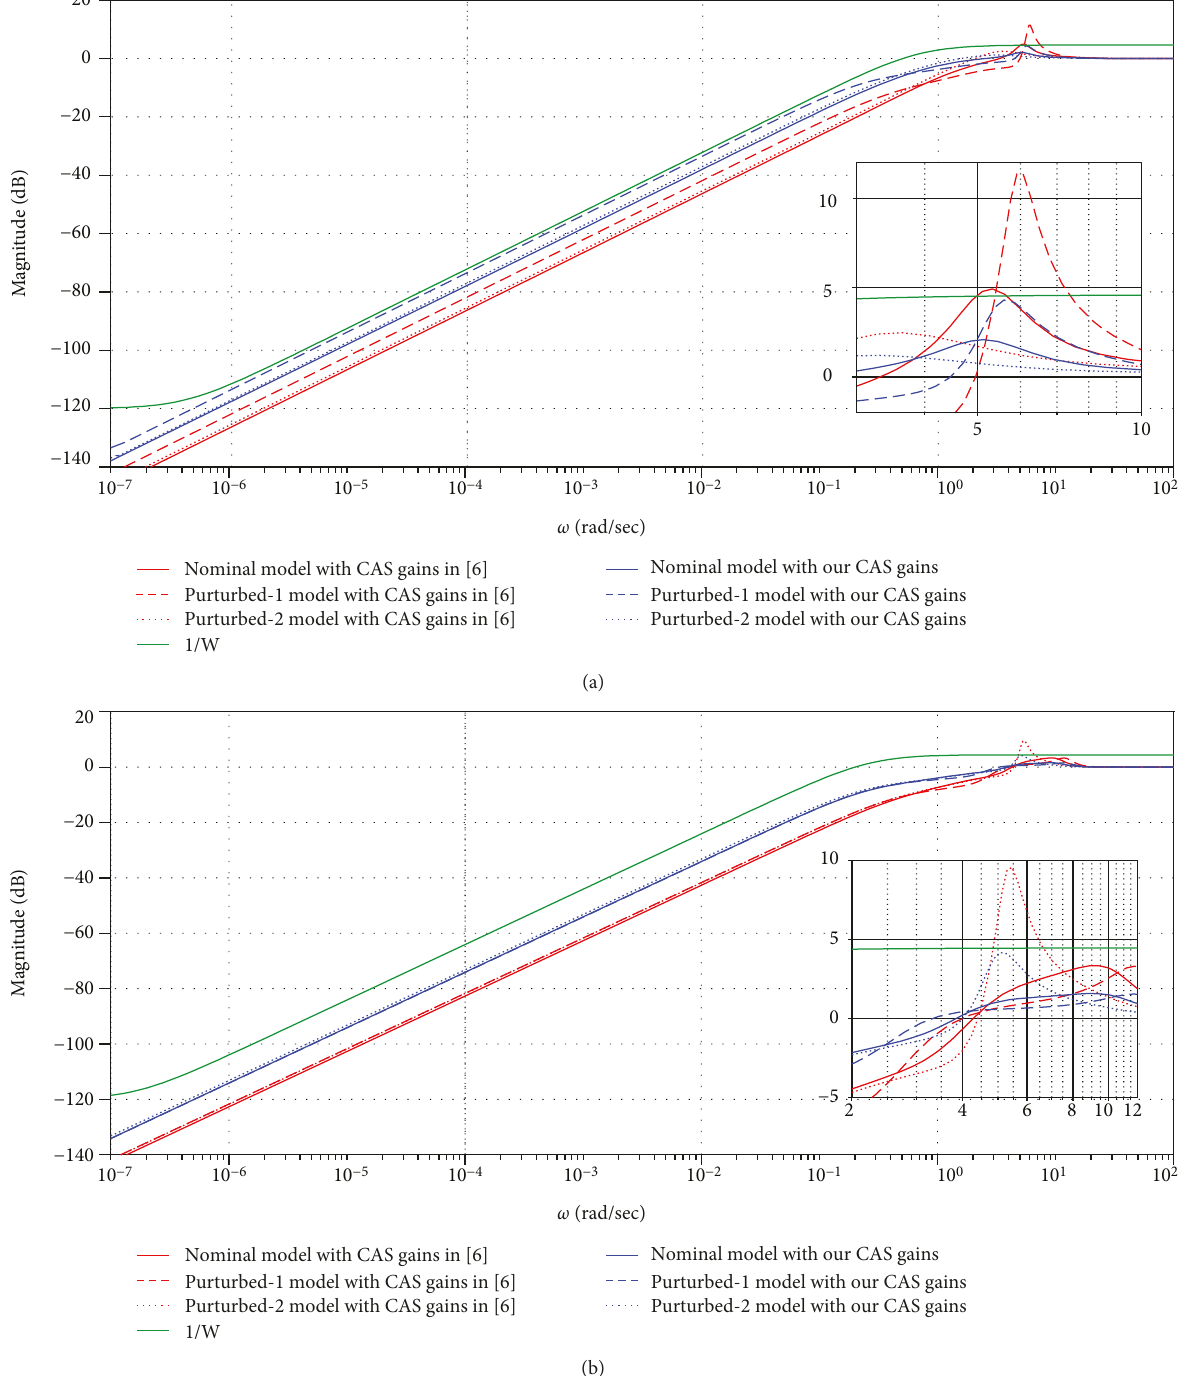
Figure 6: Gain plots of closed – loop sensitivity functions using CAS gains in [6], optimized gains in Table 2, and 1/ ∣ W s ∣ at design point 4 (T30) (a) and design point 3 (T50) (b) (close – look fi gures at maximum peak gains are given in the